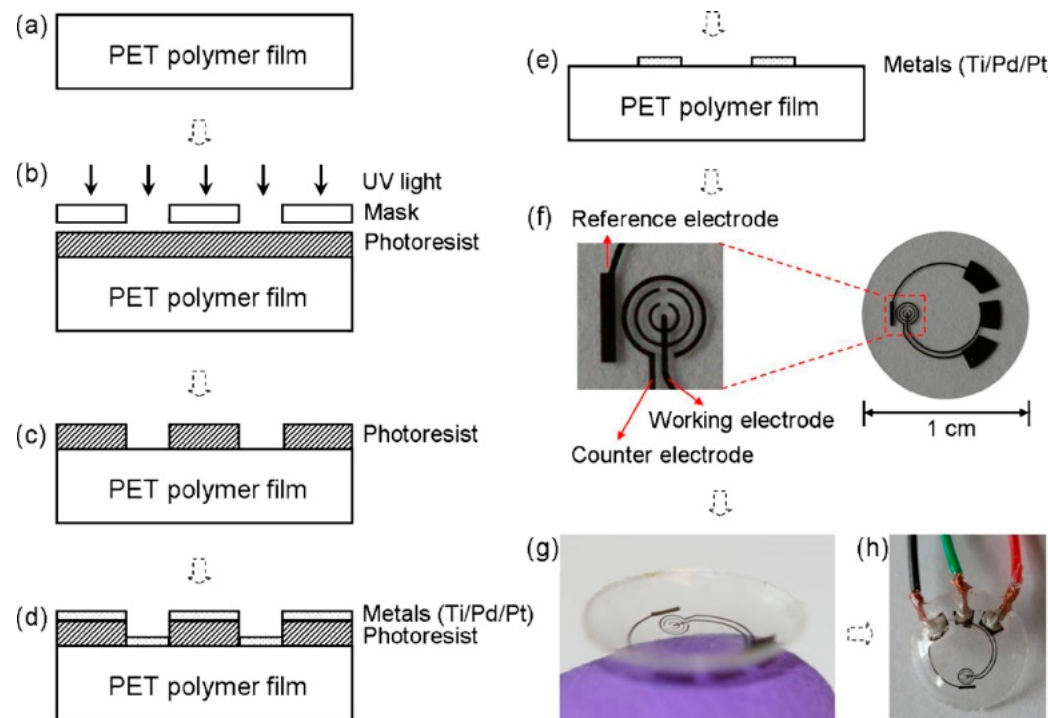
Figure 1. The sensor fabrication process and results: ( a ) a clean PET substrate is prepared; ( b ) the substrate is covered with a photoresist and exposed to UV light through a mask; ( c ) the photoresist is developed; ( d ) thin metal films are evaporated on the sample; ( e ) after lift-off, the metal pattern remains on the surface. After this step, the sensor is cut out of the polymer substrate and heat molded to the contact lens shape and functionalized with enzymes; ( f ) images of a sensor after it has been cut out of the substrate; ( g ) image of a completed sensor after molding held on a finger; ( h ) the sensor hardwired for testing. Reproduced from [5] with permission from Elsevier.